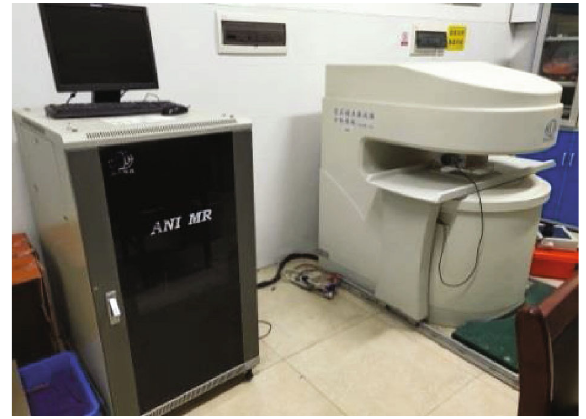
Figure 1: Rock magnetic resonance imaging of